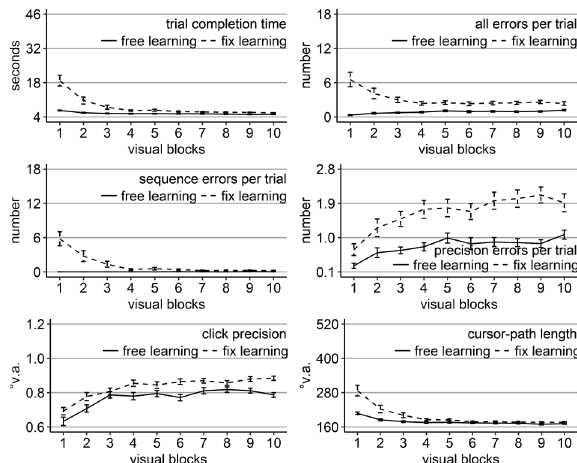
Figure 6. Performance measures during the learning phase of Experiment 3: Trial completion time in seconds, numbers of all errors, sequence errors, and precision errors per trial, click precision in °v.a., and cursor-path length in °v.a. (y-axes) over the course of the ten visual blocks (x-axes) for the two learning groups (free gaze as solid line and fix gaze as dashed line). Error bars represent standard errors of the mean.